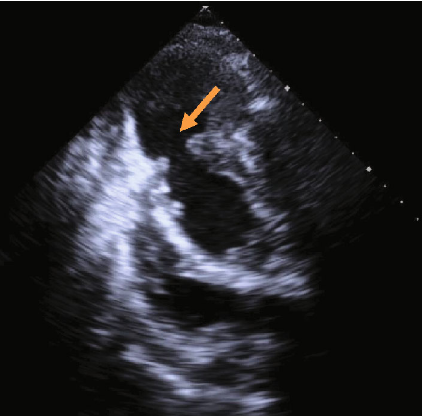
Figure 1: Left ventricular pseudoaneurysm formation, the perforation located at the apex with the size of 19mm.